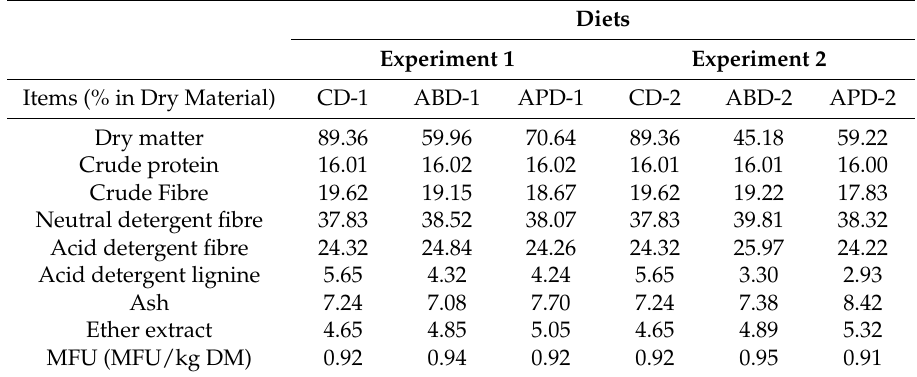
Table 2. Chemical composition (% of DM) of diets containing or not containing artichoke by-products (plant and outer bracts) in the Experiment 1 (12.5% inclusion) and Experiment 2 (25%